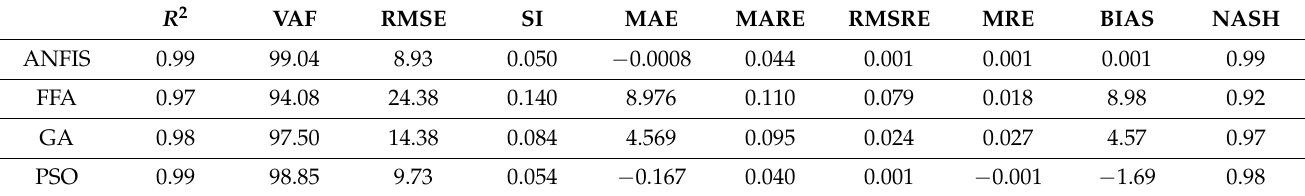
Table 2. Summary of model accuracy indicator test for the training data set (for the first combination data set), which was calculated in Excel.